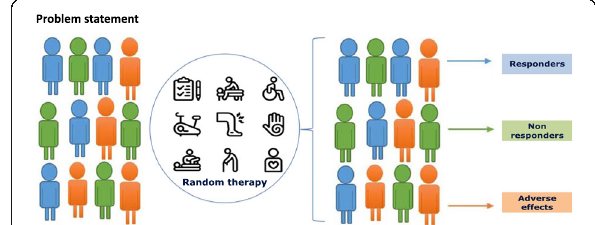
Fig. 1 (abstract P73). Visualisation of the consequence of random physiotherapeutic interventions in patients with headache